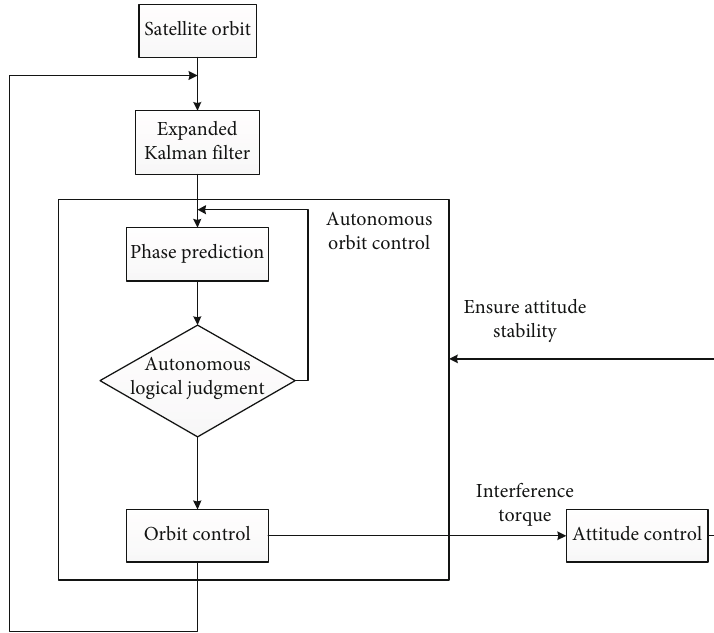
Figure 2: The fl ow chart of autonomous phase